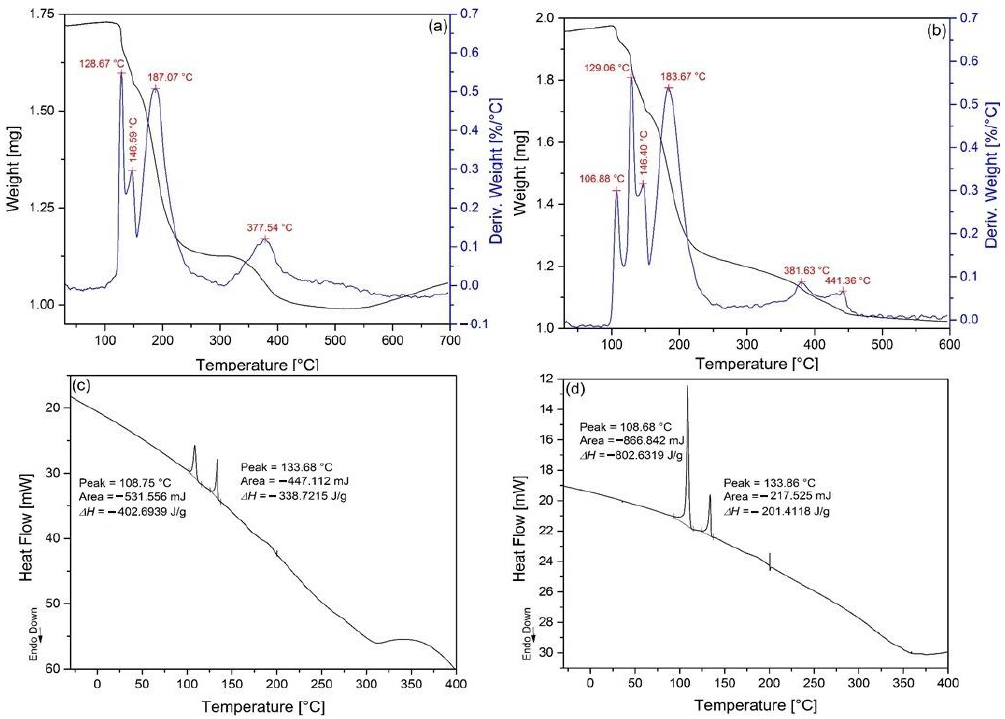
Figure 8. The TG and DTG curve of compound 1 in ( a ) air and ( b ) in an inert atmosphere. The DSC curve of compound 1 in ( c ) air and ( d ) in an inert atmosphere.